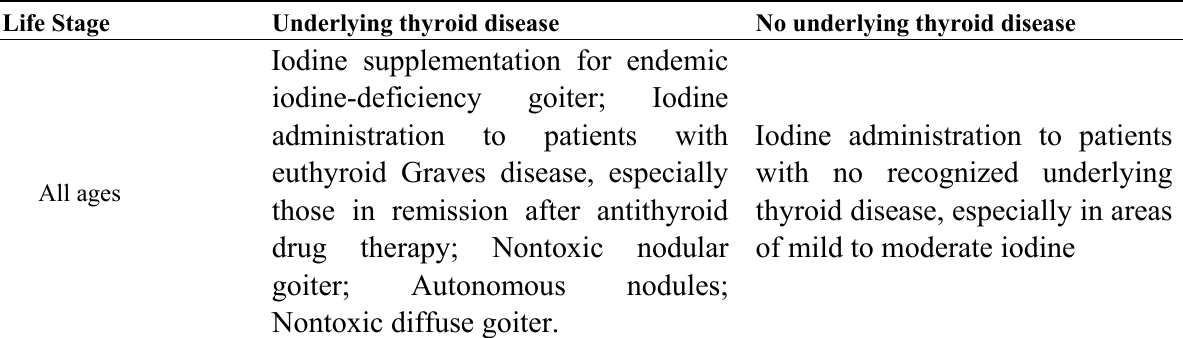
Table A2. Risk groups for iodine-induced